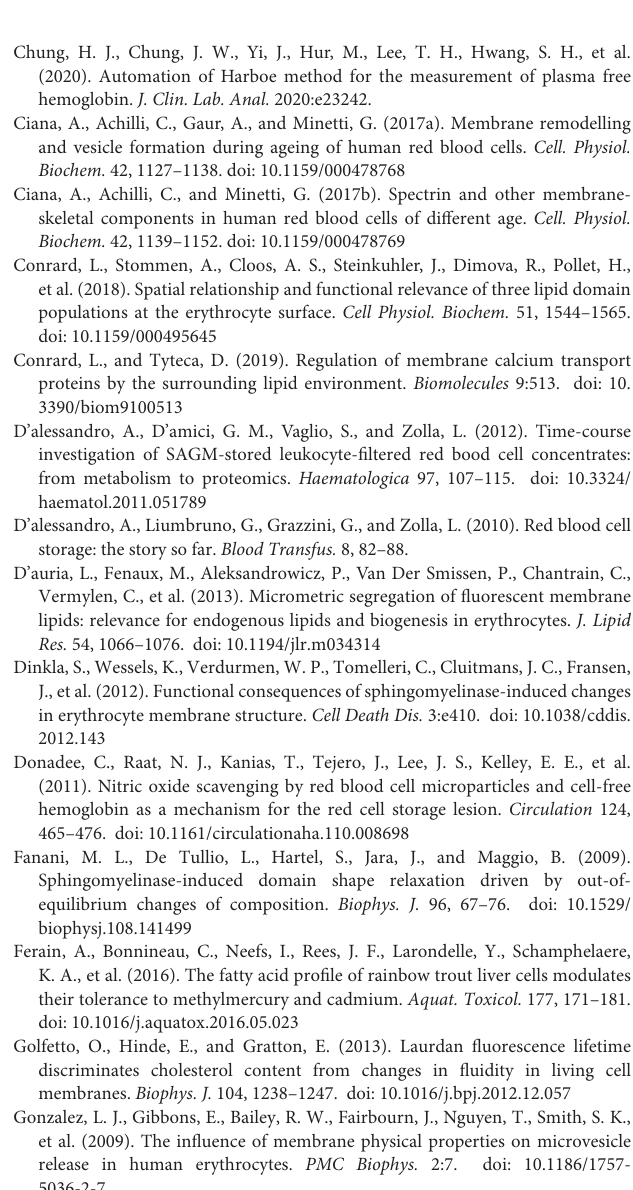
further classified according to the length of their carbon chains) and lysoPG species; and (F–H) phosphatidylethanolamine (PE, further classified according to the length of their carbon chains) and lysoPE species. Each curve depicts one lipid species; circle, saturated lipid; triangle, lipid containing at least one MUFA; inverted triangle, lipid containing at least one PUFA; black to light gray colors, short to long carbon chains. All data are expressed as % of the EVs stored for 1 week and are means ± SD of 4 replicates from 1 experiment representative of 2. FIGURE S9 | Inhibition of the aSMase activity by amitriptyline specifically increases the abundance of sphingomyelin-enriched domains. Whole blood was incubated or not (CTL, open columns) with amitriptyline ( + AMI, black columns) for 1h. Isolated plasmas were then tested for aSMase activity (A) while isolated RBCs were analyzed for the abundance of lipid domains (B) . (A) aSMase activity determined as in Figure 4H . Data are expressed in % of CTL. (B) Sphingomyelin (SM)- and GM1-enriched domain abundance determined as in Figure 5 . Data are expressed in % of CTL (means ± SEM of 3–4 independent experiments; Wilcoxon signed rank